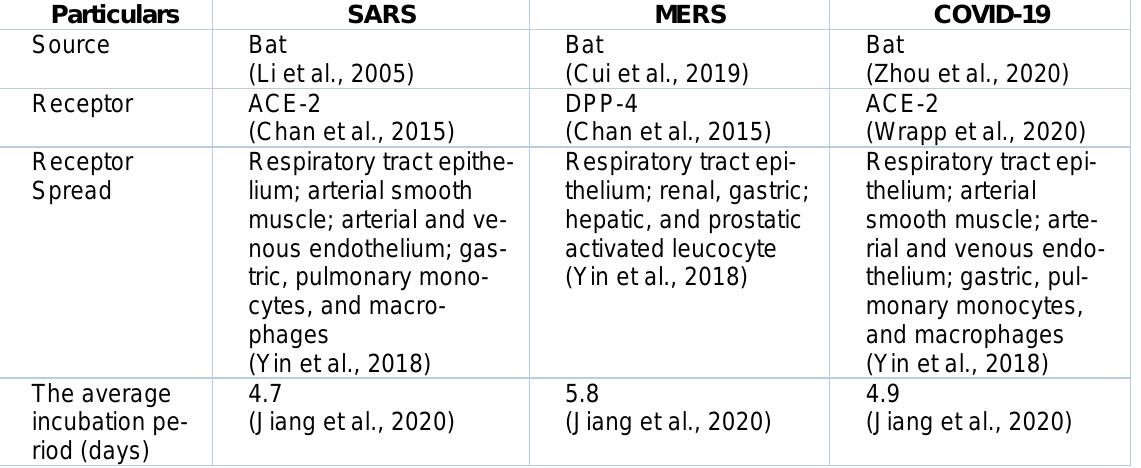
Table 2: Comparability of some epidemiological characteristics of SARS-CoV-1, MERS-CoV,